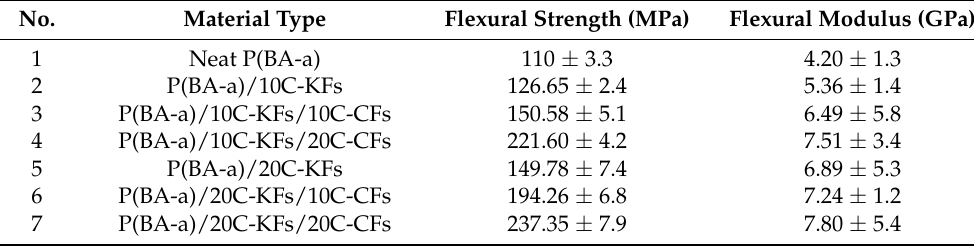
Figure 6. Bending properties of the hybrid benzoxazine composites. Table 4. Bending test results of the neat benzoxazine and the hybrid composites.